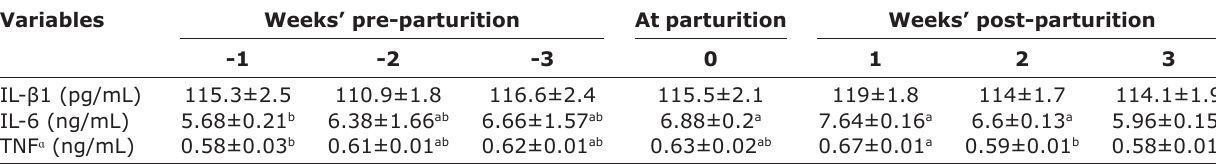
Table-3: Pro-inflammatory cytokines in serum before and after parturition and on the day of parturition at the following time points.